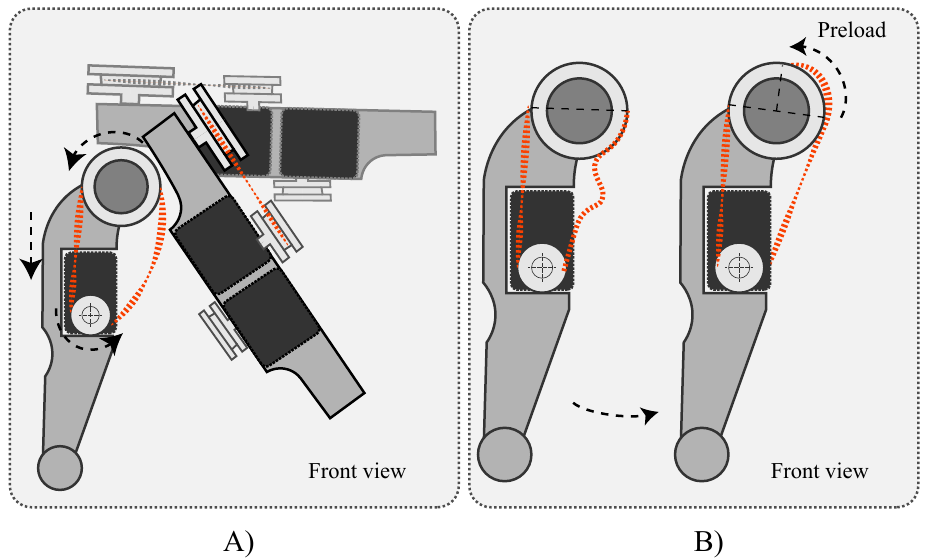
Figure 7. Mechanical design of CASTOR’s arm. ( A ) illustrates the joint movement concerning the actuator. ( B ) shows the adjustment process to change the system stiffness in the joint. The red lines represent the bioinspired elastic